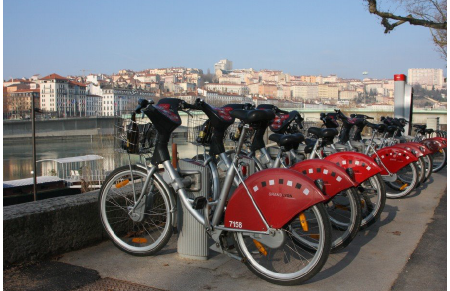
Figure 2. Vélo’v bicycle sharing system in Lyon.